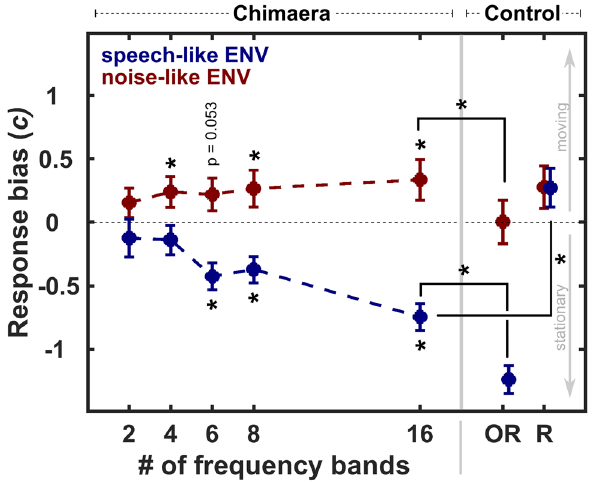
Figure 3. Response bias for sound motion across conditions for each ENV type. Response bias ( c ; mean ± sem) is plotted as a function of chimaera and control conditions, with ENV type indicated by color. Positive numbers indicate a bias towards judging sounds as moving, while negative numbers indicate a bias towards judging sounds as stationary (grey arrows). Statistical significance (see “Results”) is indicated by stars. Listeners showed a stationary perceptual bias for chimaera stimuli that had a speech-like ENV (blue) and at least six frequency bands. By contrast, chimaera stimuli with a noise-like ENV (red) and 4, 8 or 16 frequency bands induced a moving perceptual bias. Bias differed significantly for control conditions, in which listeners showed no bias for OR SMN , while the strongest stationary bias was induced for OR S . Removing sound content intelligibility, R S , removed the stationary bias that was observed in listeners when the same sound’s content was intelligible, SC 16 .